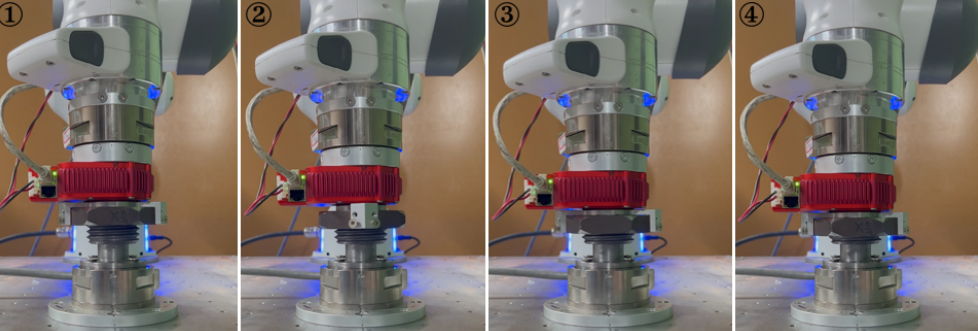
Figure 11. Snapshot of bolting experiment: when the nut is rotated and pressed down using the robot manipulator, it is fastened with the bolt over time and goes down ( 1 → 4